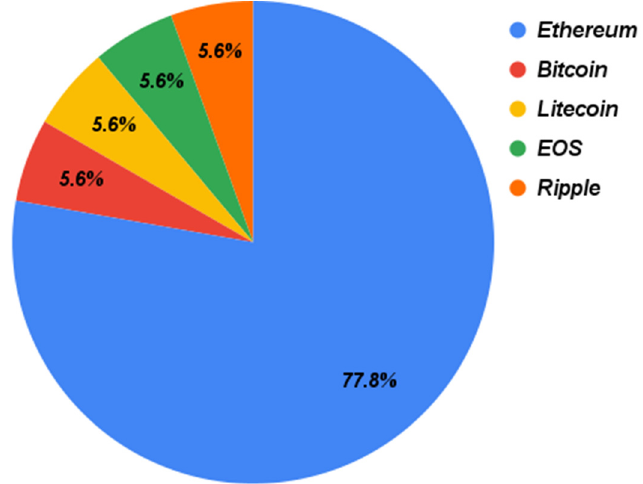
Figure 7. The adopted BC platforms in the primary papers.